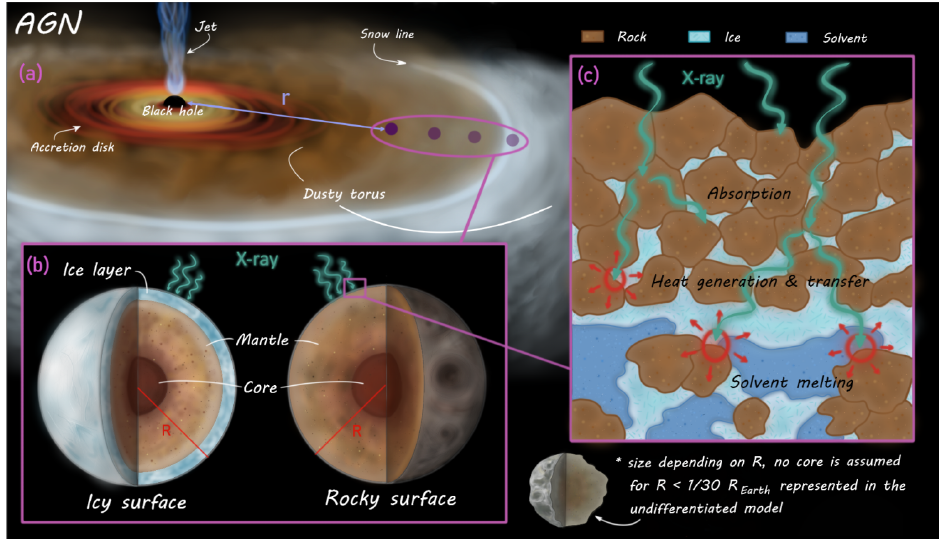
Figure 1. Schematic outline of modelling process and considered variations: ( a ) We investigate a sample of 20 Seyfert 1 active galactic nuclei (AGNs), taking an average X-ray spectrum as input “source” for simulations. Simulated bodies orbit this source at distances between 10% and 100% of the snowline distance within the toroidal plane, at an angle of 68°. ( b ) Attenuation of the X-ray radiation is calculated for two proposed crusts of the model bodies: One of an initially frozen fresh water, methane, and ammonia mixture, and one crust consisting of 50% rocky compounds combined with 50% frozen solvents. The solvent mixture on the rocky model features three variations between fresh water, NaCl –, and CaCl 2 –saltwater respectively. ( c ) Attenuated energy is used as a continuous source term for a 1D-heat transfer model. Each timestep of the model, solvent phase states are determined and thermochemical properties are adjusted in turn. After a timeframe determined to reach sufficient thermal equilibrium, results are read out and displayed. Further variabilities beyond this core process include how the results were impacted by different model body radii, changes to the radiation source, impact of different model body densities (allowing concrete relations to known and relevant solar system bodies) and determining a smallest viable body